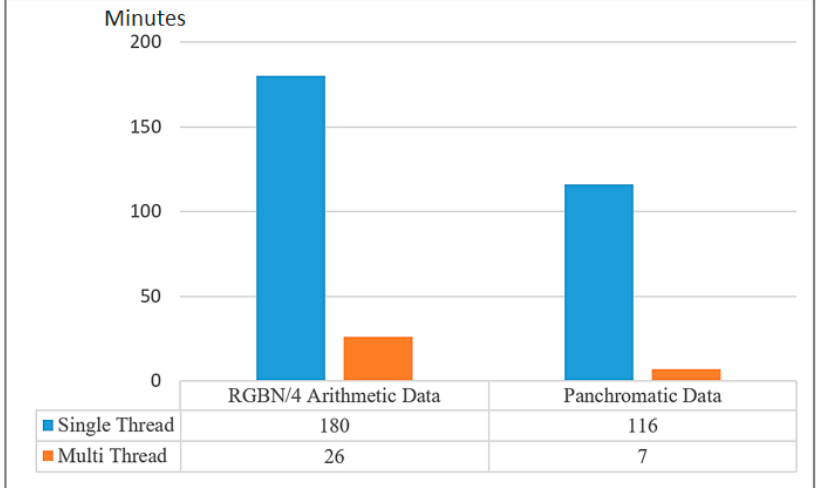
Figure 9. Comparison of the process times for single and multithread approaches.